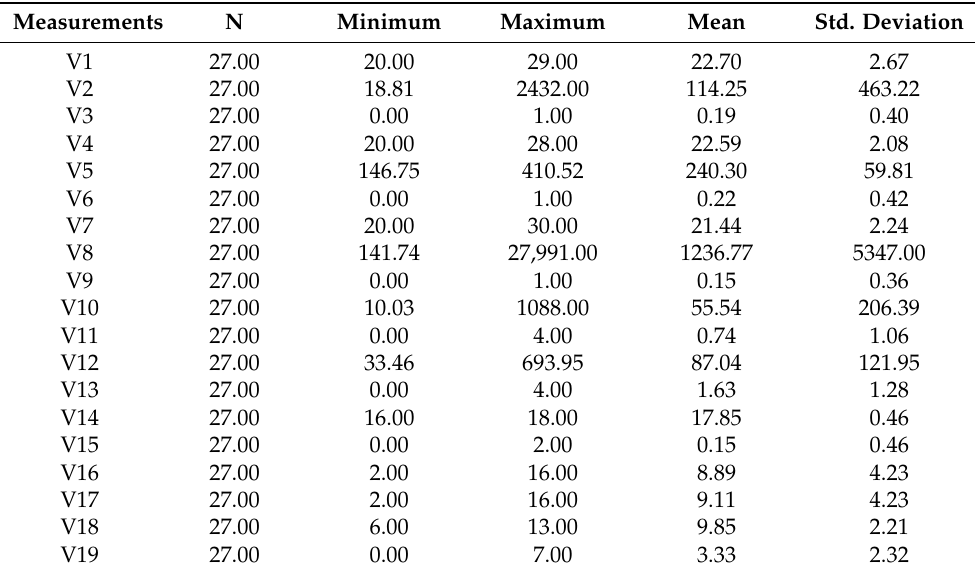
Table 3. Description of the measurements performed.